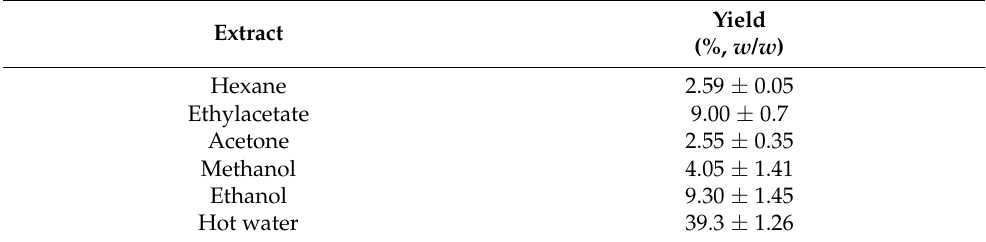
Table 1. Extraction yields of Ilex x Wandoensis